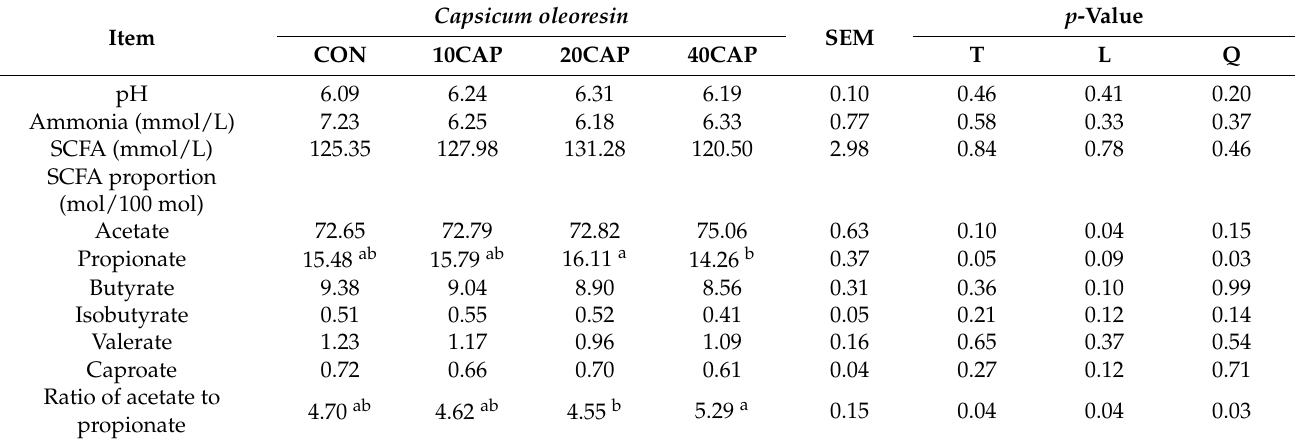
Table 3. Fermentation parameters as affected by Capsicum oleoresin (CAP) supplementation in vivo.